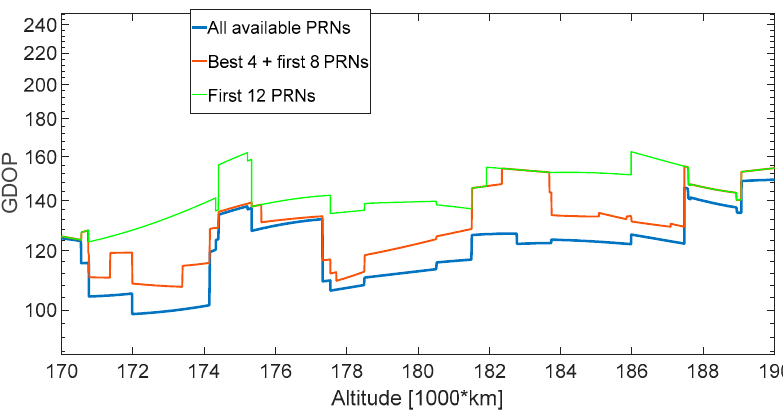
Figure 47. Zoomed-in version of Figure 45 between 170,000 km and 190,000 km.